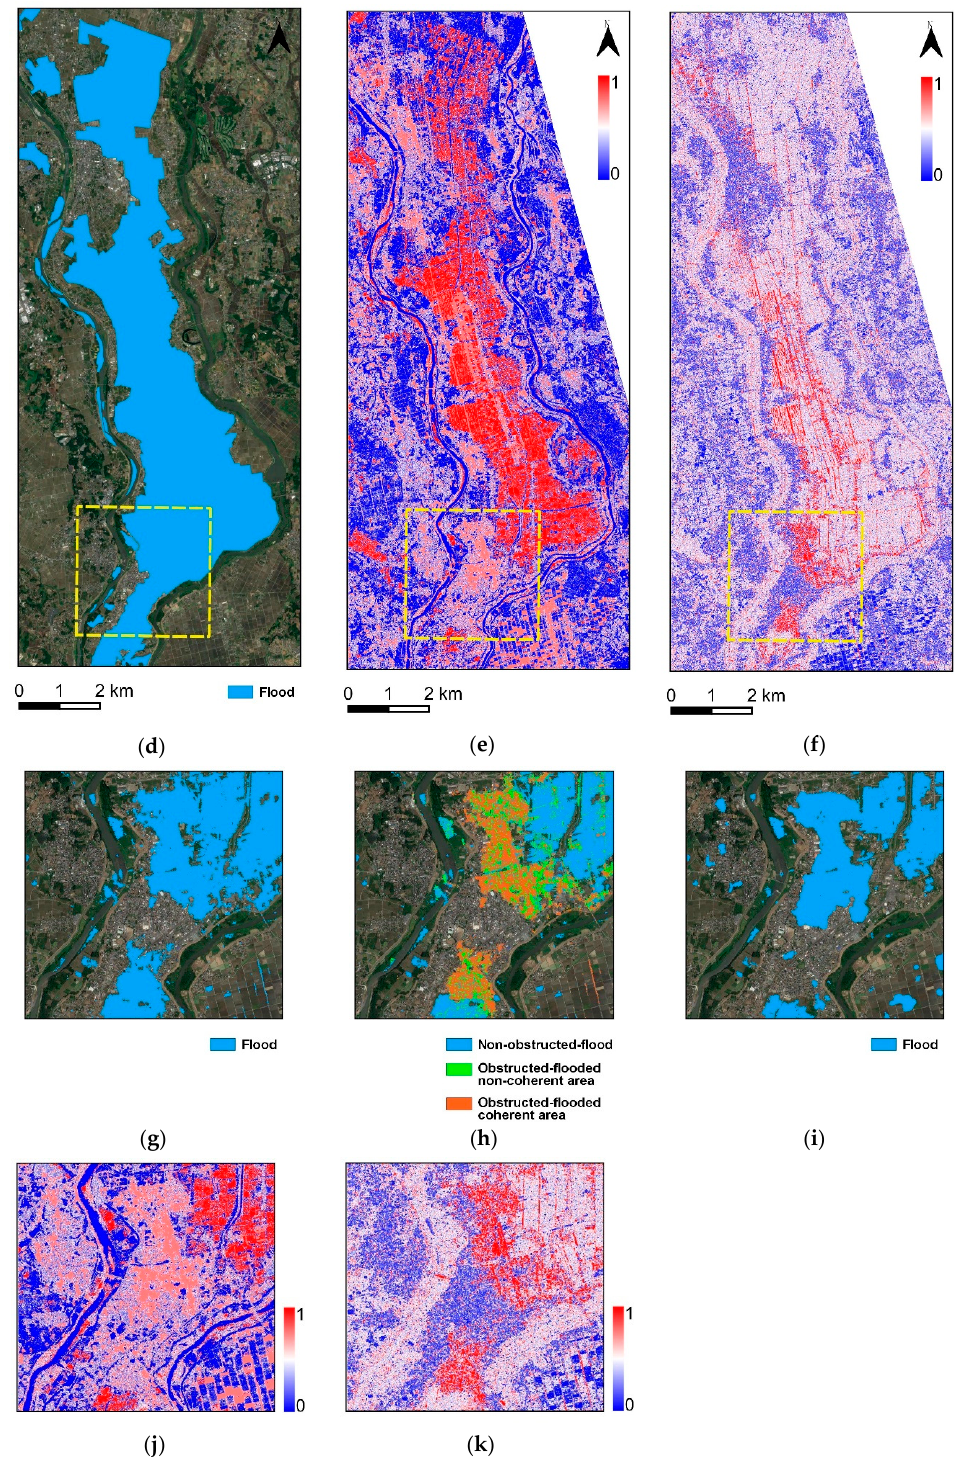
Figure 6. Flood extent maps of the Joso study area: ( a ) Binary flood extent based on the fusion of σ ◦ and γ ; ( b ) Flood category map of ( a ); ( c ) Binary flood extent based on σ ◦ alone; ( d ) Reference flood mask derived from high-resolution aerial photograph provided by the Geospatial Information Authority of Japan (GSI); ( e ) Flood posterior probability conditioned on σ ◦ ; ( f ) Flood posterior probability conditioned on γ ; ( g ) Zoom-in of the yellow box in ( a ); ( h ) Zoom-in of the yellow box in ( b ); ( i ) Zoom-in of the yellow box in ( c ); ( j ) Zoom-in of the yellow box in ( e ); ( k ) Zoom-in of the yellow box in ( f